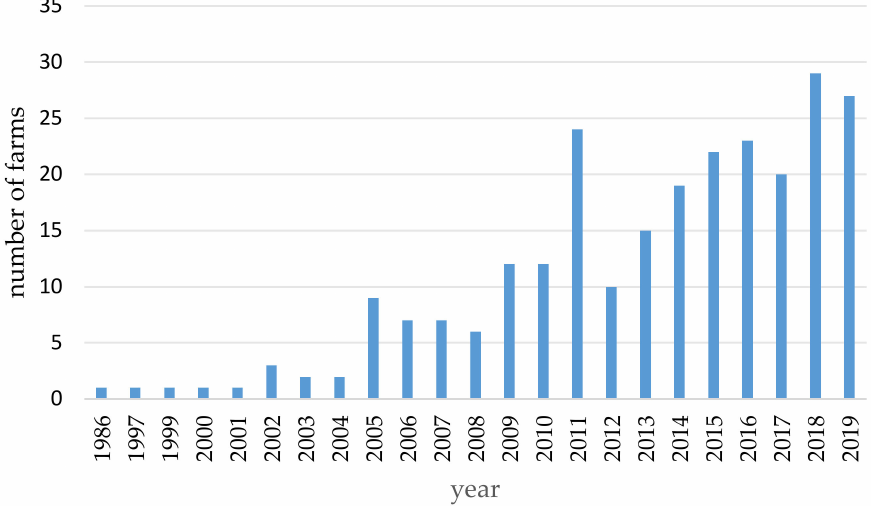
Figure 2. Number of new stocks in the respective year (single choice; n = 254). A total of 3062 alpacas were recorded on 220 farms and a total of 741 llamas were kept on 75 farms (Tables 2 and 3). About one third of the male alpacas and more than half of the male llamas were